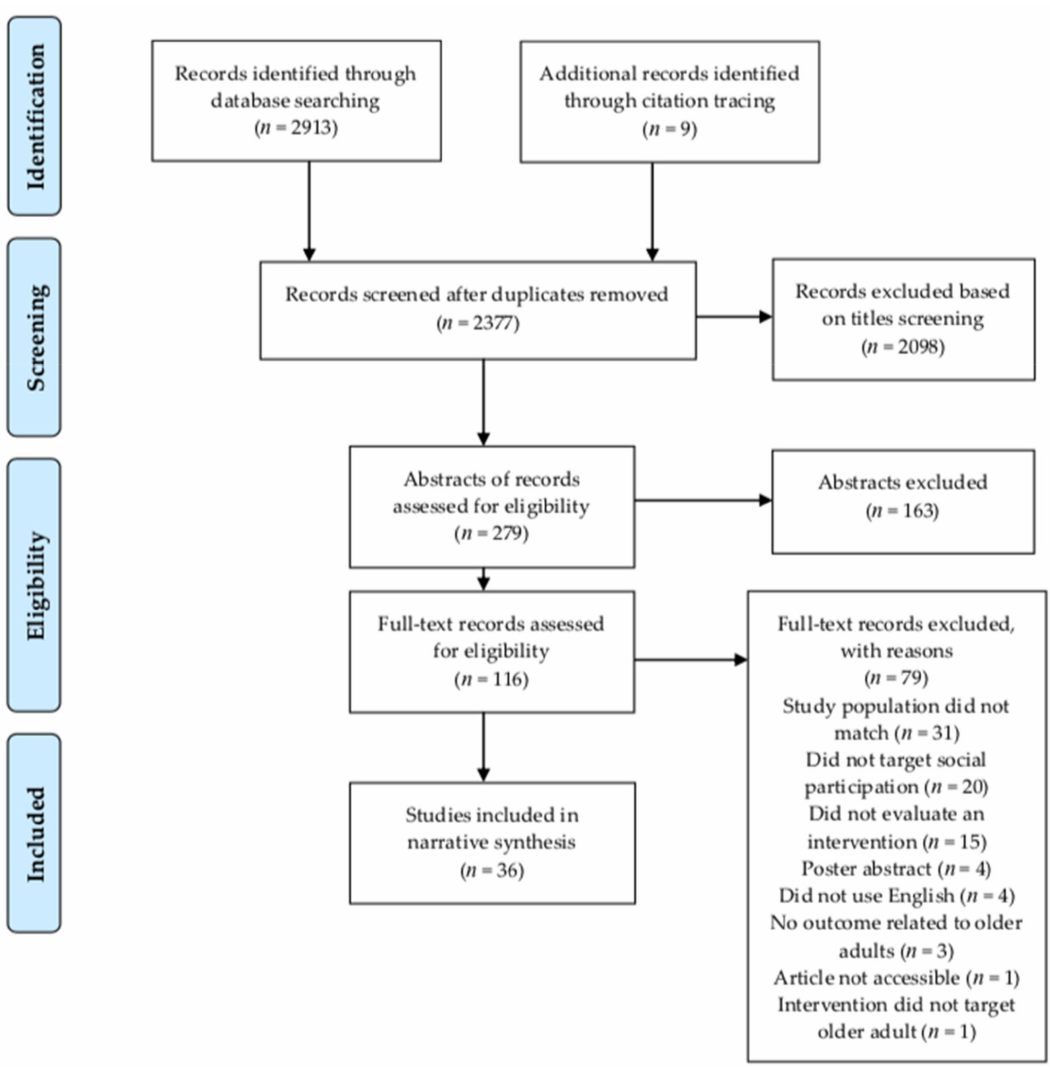
Figure 1. Study selection flowchart based on PRISMA